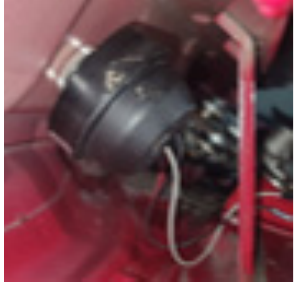
Figure 3. Setup of the ESG–cowl pair.